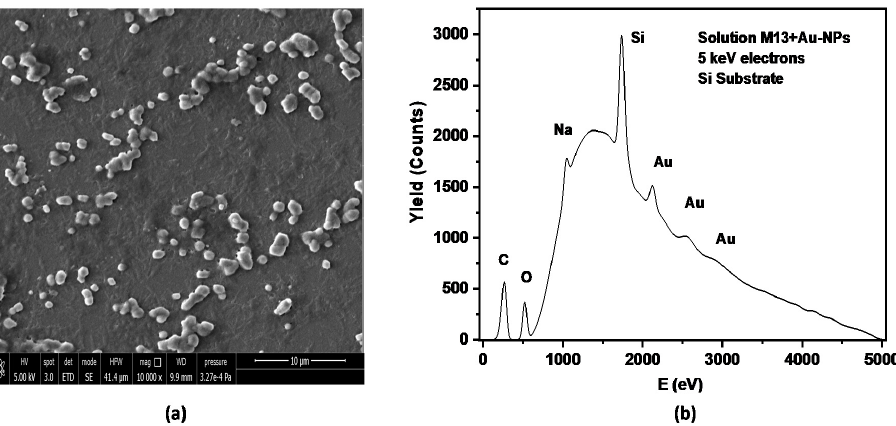
Figure 2. SEM images of the M13 phages with Au NPs compounds ( a ) and relative EDX spectrum of the drops deposited on silicon substrate ( b